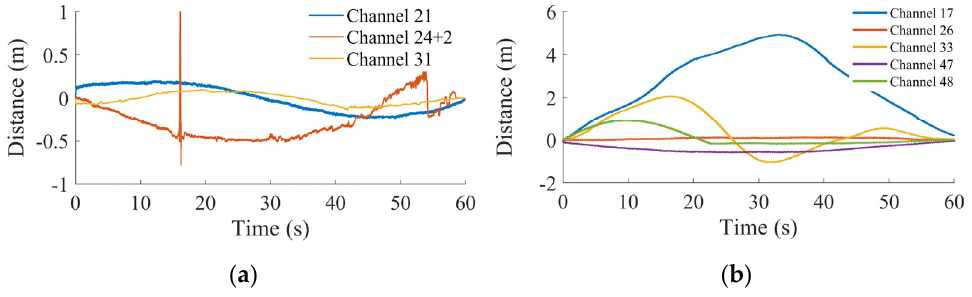
Figure 8. Carrier phase ranging in static scenario, ( a ) Luoyang, ( b ) Wuhan.